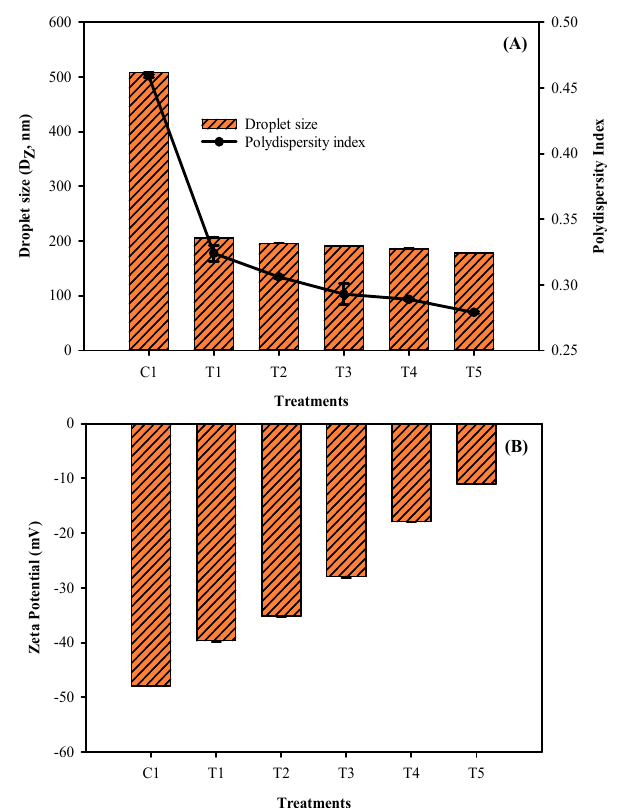
Figure 3. Droplet size ( A ), polydispersity index ( A ) and zeta potential ( B ) of the mung bean phyto-film that incorporated LPE and was processed under sonication.